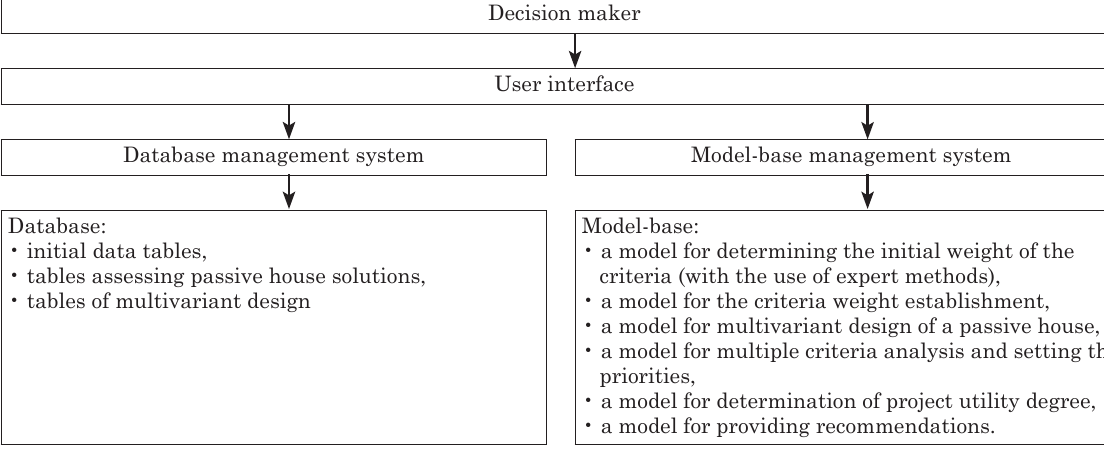
figure 1. The components of PHDMCDS